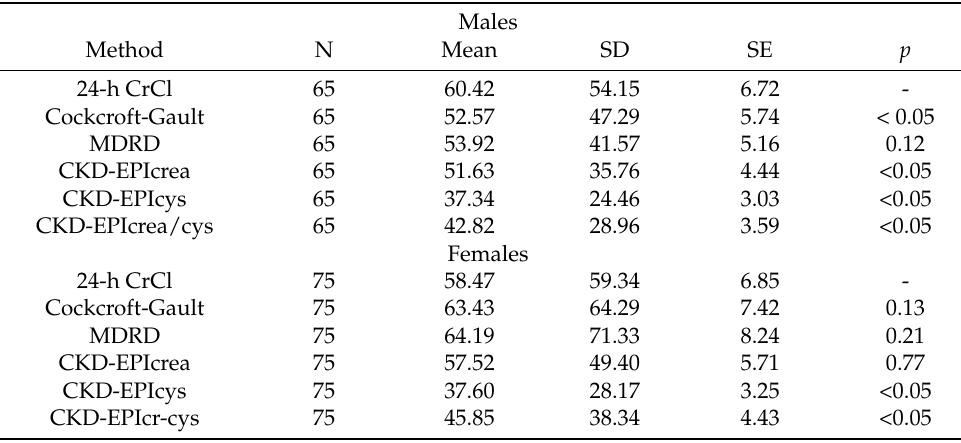
Table 6. Comparison of methods (mL/min) by gender.